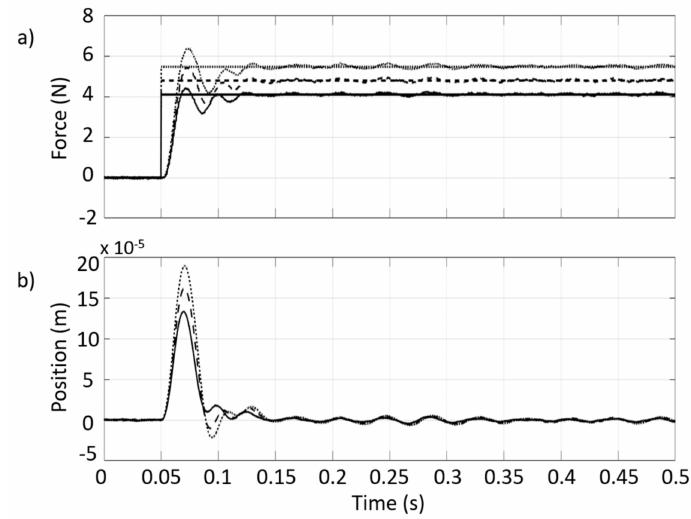
Figure 4. Step excitation at different force amplitudes ( i d = 0.3 A, 0.35 A, 0.4 A). ( a ) Nominal vs. estimated applied force. ( b ) Displacement of the